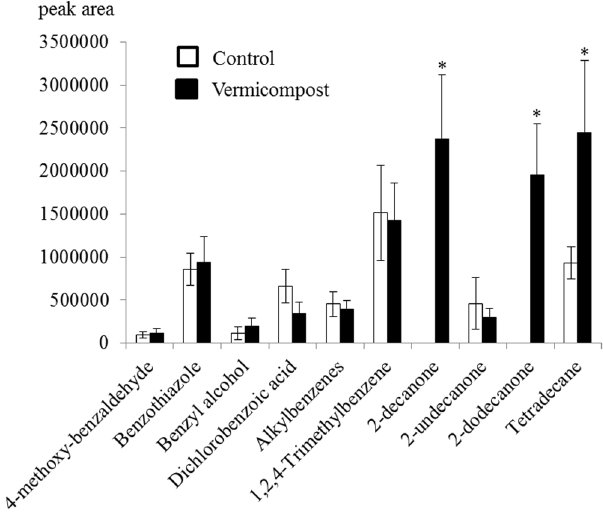
Figure 3. Volatiles (mean ± SE) emitted by Nerium oleander plants grown in a potting soil initially containing a sterile (Control)/non sterile (Vermicompost) inoculum and after attack by Aphis nerii. V 1 : 4-methoxy- benzaldehyde (P = 0.600, F = 0.323), V 2 : benzothiazole (P = 0.627, F = 0.276), V 3 : benzyl alcohol (P = 0.091, F = 4.902), V 4 : dichlorobenzoic acid (P = 0.090, F = 4.962), V 5 : alkylbenzenes (P = 0.403, F = 0.873), V 6 : 1,2,4-trimethylbenzene (P = 0.831, F = 0.052), V 7 : 2-decanone (P = 0.001, F = 62.381), V 8 : 2-undecanone (P = 0.830, F = 0.053), V 9 : 2-dodecanone (P = 0.001, F = 63.562), V 10 : tetradecane (P = 0.005, F =